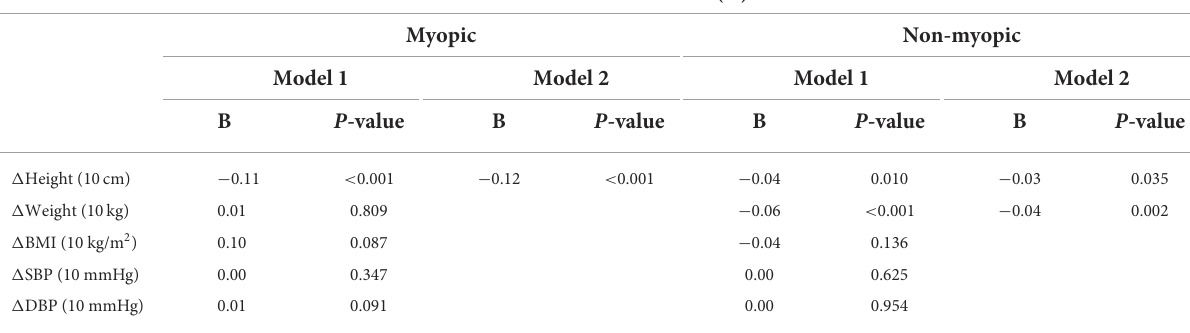
TABLE 6 Multiple linear regression models of SER changes by change in height, weight, BMI, SBP, and DBP for myopic and non-myopic children